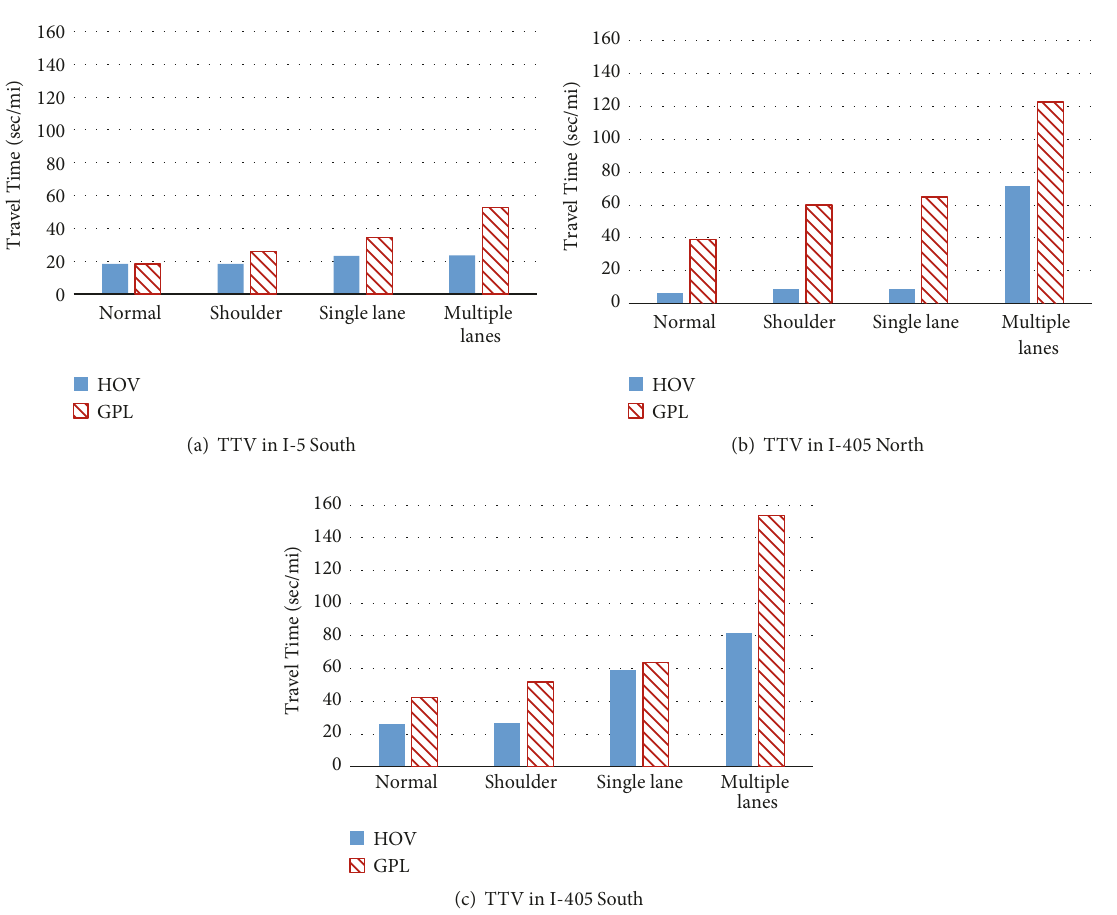
Figure 5: Comparison of travel time variability between HOV lanes and GPLs on I-5 South, I-405 North, and I-405 South. (a) TTV in I-5 South. (b) TTV in I-405 North. (c) TTV in I-405